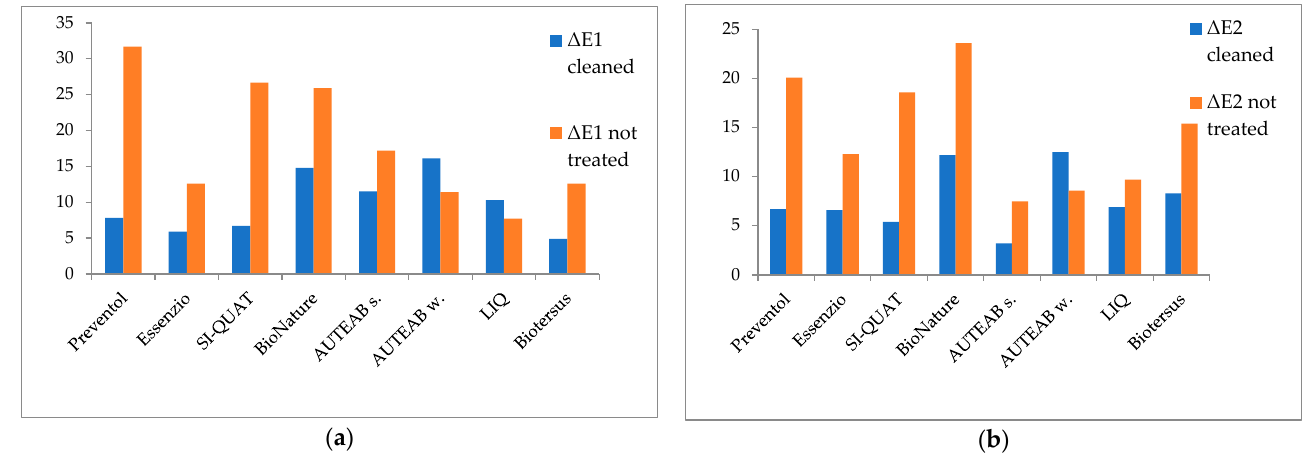
Figure 7. Histogram reporting the Δ E* parameter associated to the cleaned zone and the non-treated zone of Area 1 ( a ) and Area 2 ( b ). Measures taken seven months after the cleaning treatment. Standard deviation 0.5 < SD < 3.2.